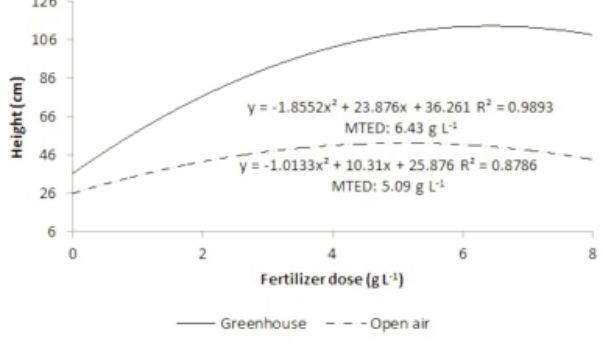
Fig. 1 ­ Plant height (cm) of the peach plants cv. Capdeboscq, in relation to the dosage of the controlled­release fertilizer (CRF) and two cultivation environments, 90 days after transplanting.